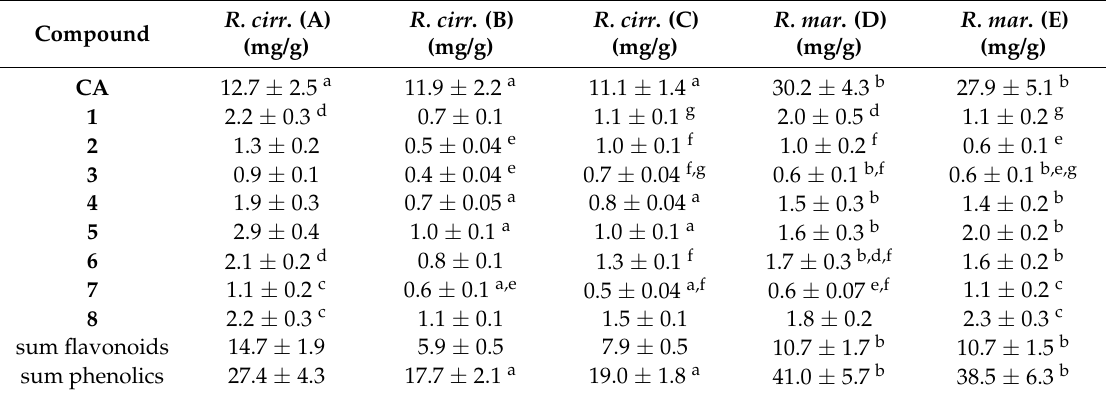
Table 3. Quantitative amounts of individual flavonoids and phenolic acids in leaves of Ruppia